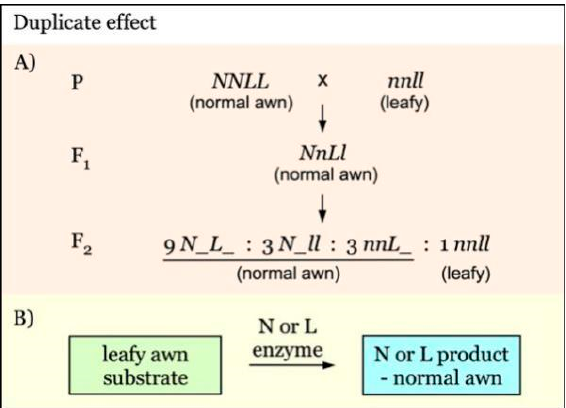
Figure 5. Model of interaction of awnness genes with a duplicate effect. ( A ). N and L are independent awnness genes with a duplicate effect. The presence of either N or L is sufficient to result in the formation of normal awns. In the absence of both genes ( nnll ), leafy awns are developed. ( B ). N and L enzymes have a redundant function and only one of them is required for converting the leafy awn substrate to the normal awn phenotype.